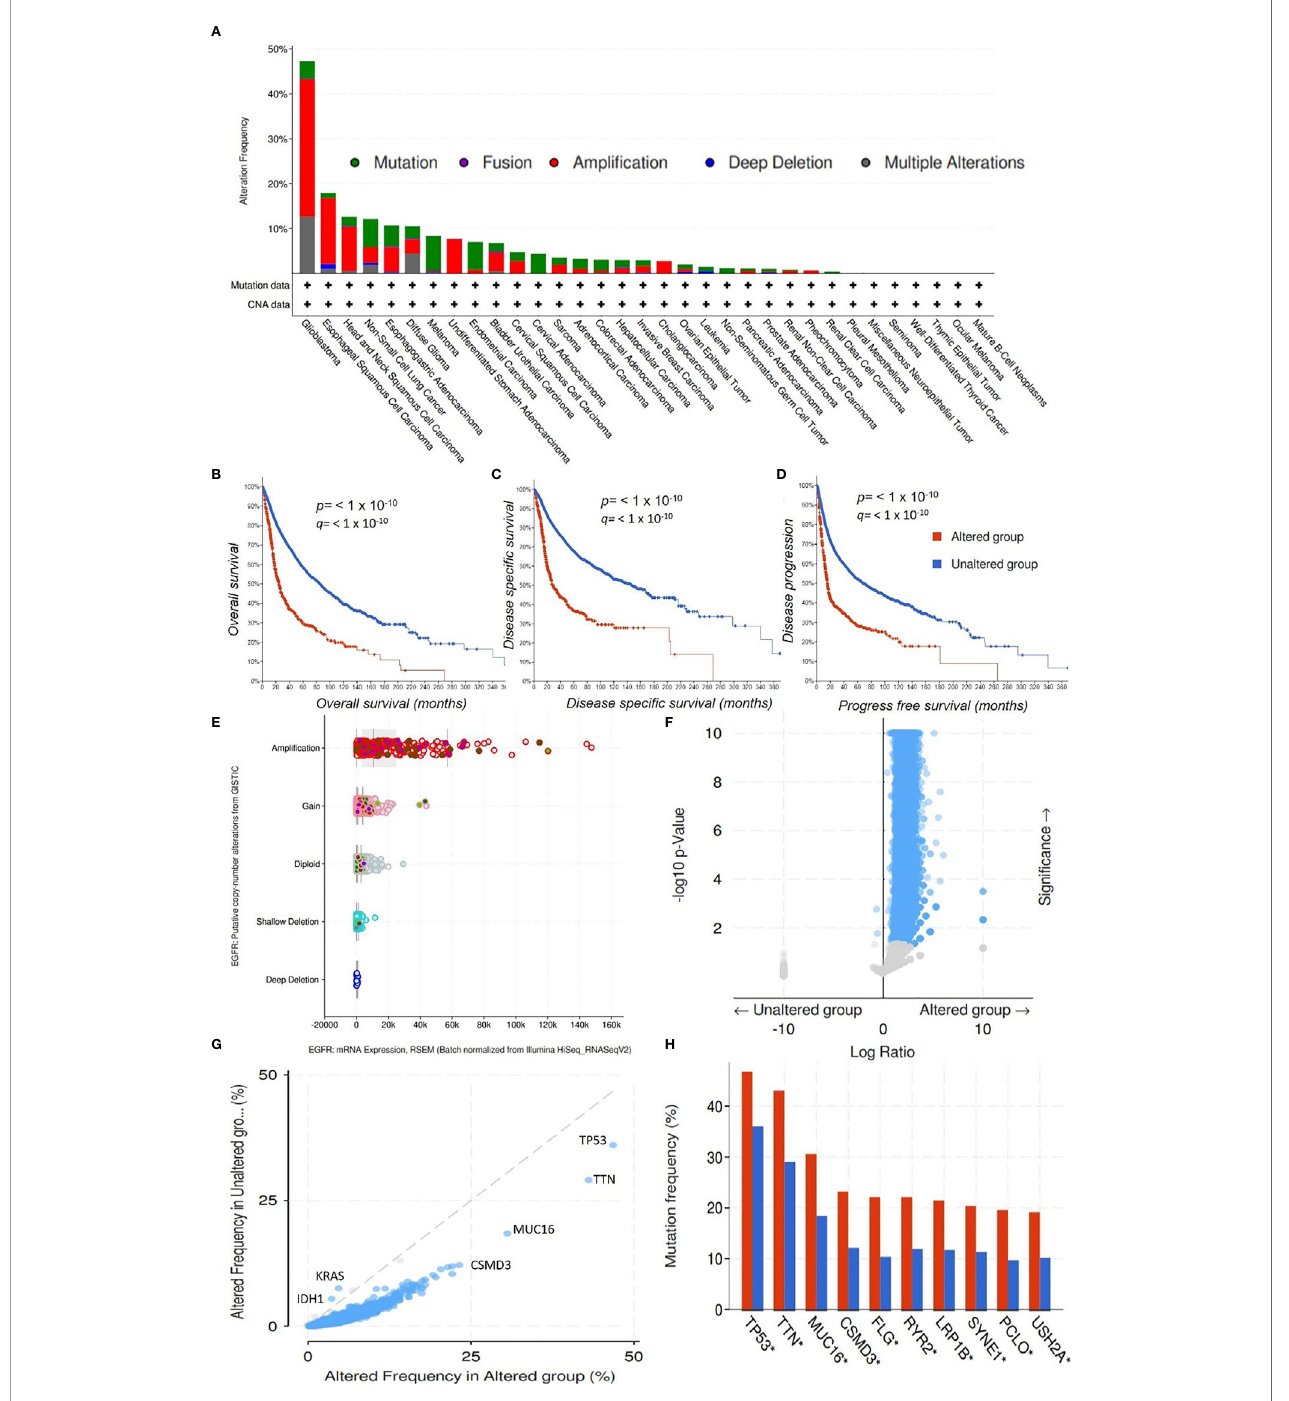
FIGURE 6 | Genomic alterations in the epidermal growth factor receptor (EGFR) are associated with poor prognoses of cancer cohorts. (A) Bar graph showing alteration frequencies of the EGFR in cohorts of different cancer types. The most common alteration in the EGFR gene was ampli fi cation. Kaplan-Meir survival curve of (B) overall survival, (C) disease-speci fi c survival, and (D) disease-progression survival of cancer cohorts with altered EGFR and unaltered EGFR genes. Cohorts with altered EGFR had low overall survival, disease-speci fi c survival, and disease-progression survival. p < 10 − 10. (E) . Bar showing the EGFR putative copy number alterations and messenger RNA expressions. (F) Heat map showing p values and signi fi cance levels of other gene mutations associated with cohorts with altered EGFR and cohorts with unaltered EGFR . (G) Line graph showing frequencies of altered genes in cancer cohorts with altered EGFR and cohorts with unaltered EGFR . (H) Bar graph showing gene mutations that were signi fi cantly enriched in both EGFR -altered and EGFR -unaltered